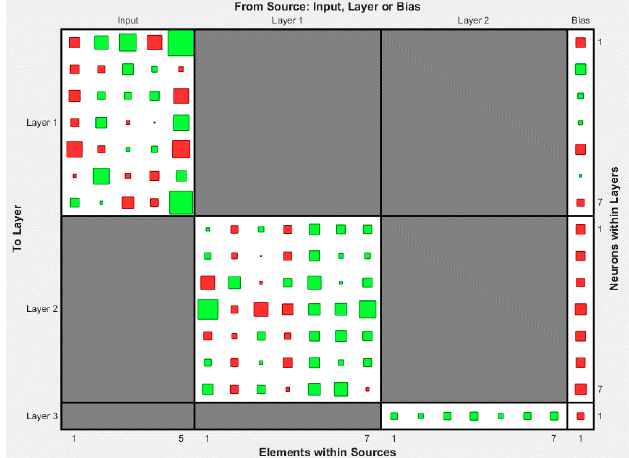
Figure 10. Final Weights and Bias Values of the optimum FF-NN model 5-7-7-1 for the case of